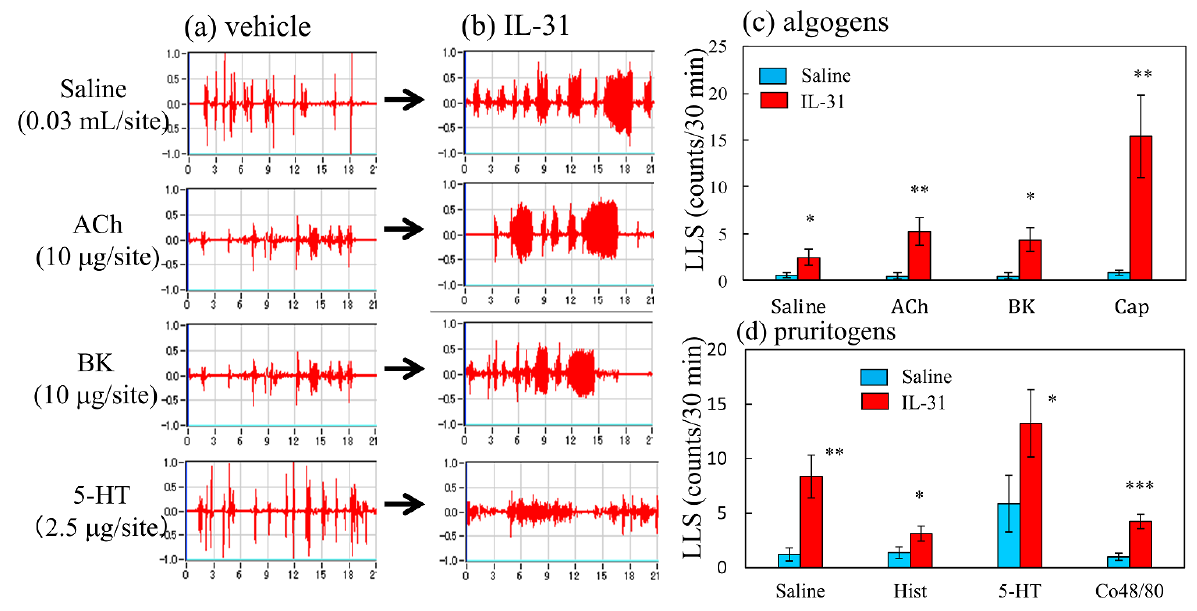
Figure 6. Effects of several algogens or pruritogens on long-lasting scratching (LLS) counts 1 h after the intravenous injection of IL-31. ( a ) Typical traces of saline-, acetylcholine-, bradykinin-, and ser- otonin-induced scratching behavior in vehicle (PBS, 10 mL/kg, i.v.)- or IL-31-administered (50 μg/kg, i.v.) BALB/c mice. Traces show the scratching behavior of the vehicle-administered mice. ( b ) Traces on the right side show the scratching behavior of IL-31-administered BALB/c mice. ( c ) Effects of IL- 31 on mice treated with acetylcholine (ACh, 10 μg/site, intradermal i.d.), bradykinin (BK, 10 μg/site, i.d.), or capsaicin (Cap, 1 μg/site, i.d.). ( d ) Effects of IL-31 on scratching counts induced by saline (0.03 mL/site, i.d.), histamine (Hist, 10 μg/site, i.d.), serotonin (5-HT, 2.5 μg/site, i.d.) or compound 48/80 (Co48/80, 10 μg/site) in mice. Each value represents the mean ± standard error (S.E.) from six mice (total of 24 mice). * p < 0.05, ** p < 0.01, and *** p < 0.001 compared with the respective values in the vehicle-administered group (Student’s t -test).